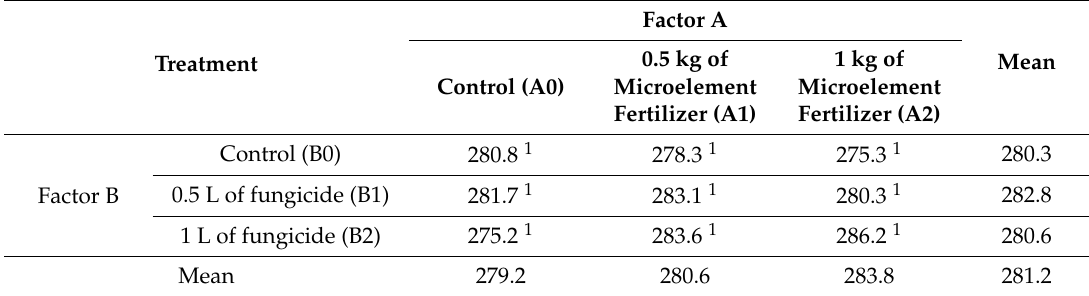
Table 5. E ff ect of micronutrients and fungicide on Maguire’s germination speed index.